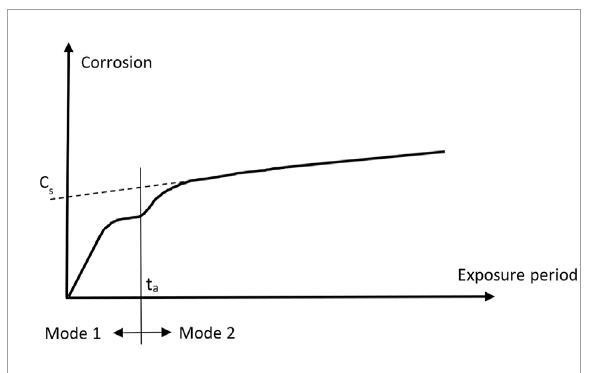
FIGURE 1 Melcher’s bi-modal model shown to be relevant for mild and low alloy steels as well as for chromium steels under various exposure conditions. Adapted from Melchers